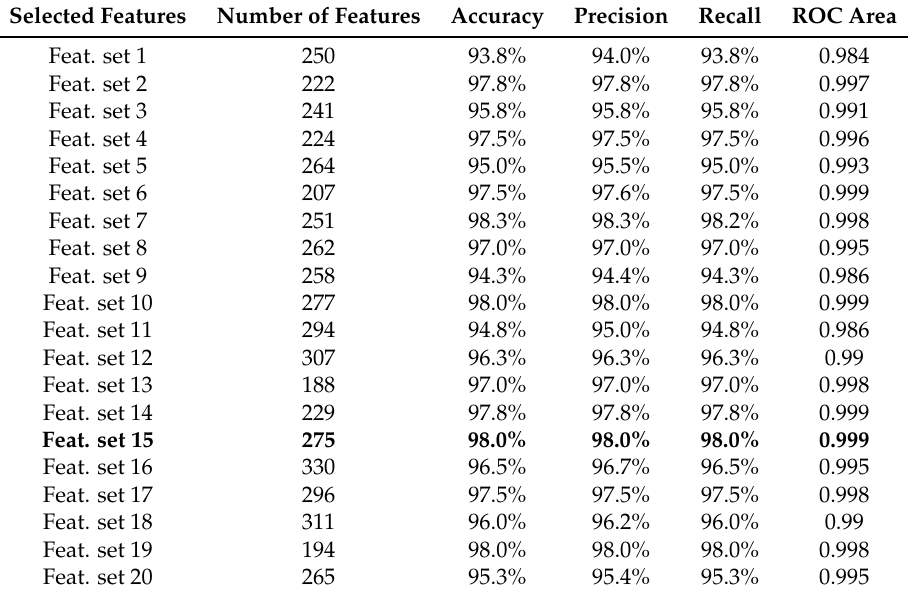
Table 3. Detection of normal or abnormal using BGWO with curvelet features.